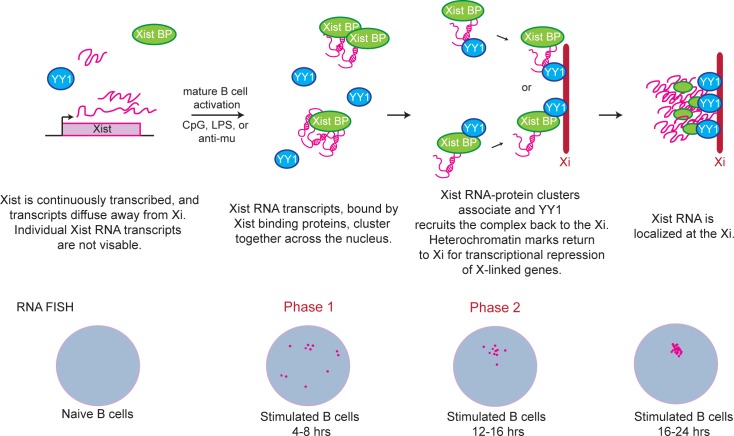
Model: Two phases for Xist RNA localization to the Xi during B cell stimulation.Naïve B cells lack detectible Xist RNA signals despite continuous Xist transcription. Xist RNA transcripts (pink) diffuse away from the Xi; YY1 protein is present, but at lower levels. During Phase 1 of Xist RNA localization (4–8 hrs post-stimulation), Xist RNA pinpoints are visible across the nucleus and RNA binding proteins cluster transcripts together to produce a visible signal by RNA FISH. During Phase 2 of localization (12–16 hrs post-stimulation), YY1 recruits Xist RNA transcripts, either directly binding RNA or indirectly interacting with Xist binding proteins (Xist BP), back to the Xi through the zinc-finger domain. Nuclei with robust Type I Xist RNA clouds have Xist RNA localized across the Xi.